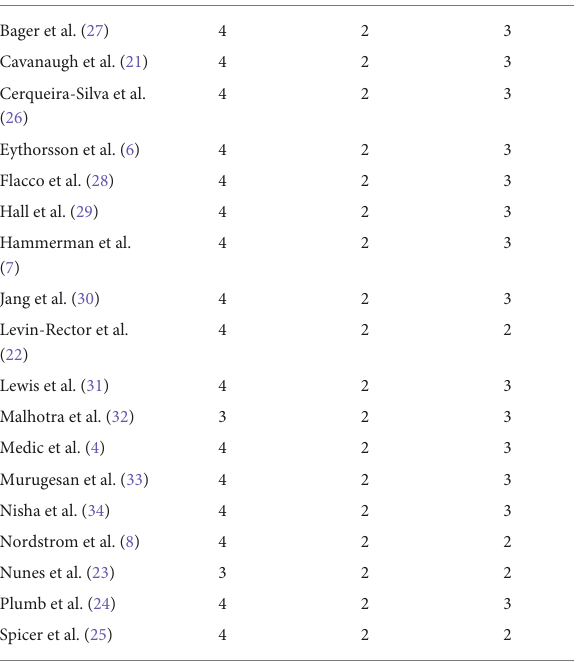
TABLE 2 Methodological quality of the included studies according to the Newcastle Ottawa